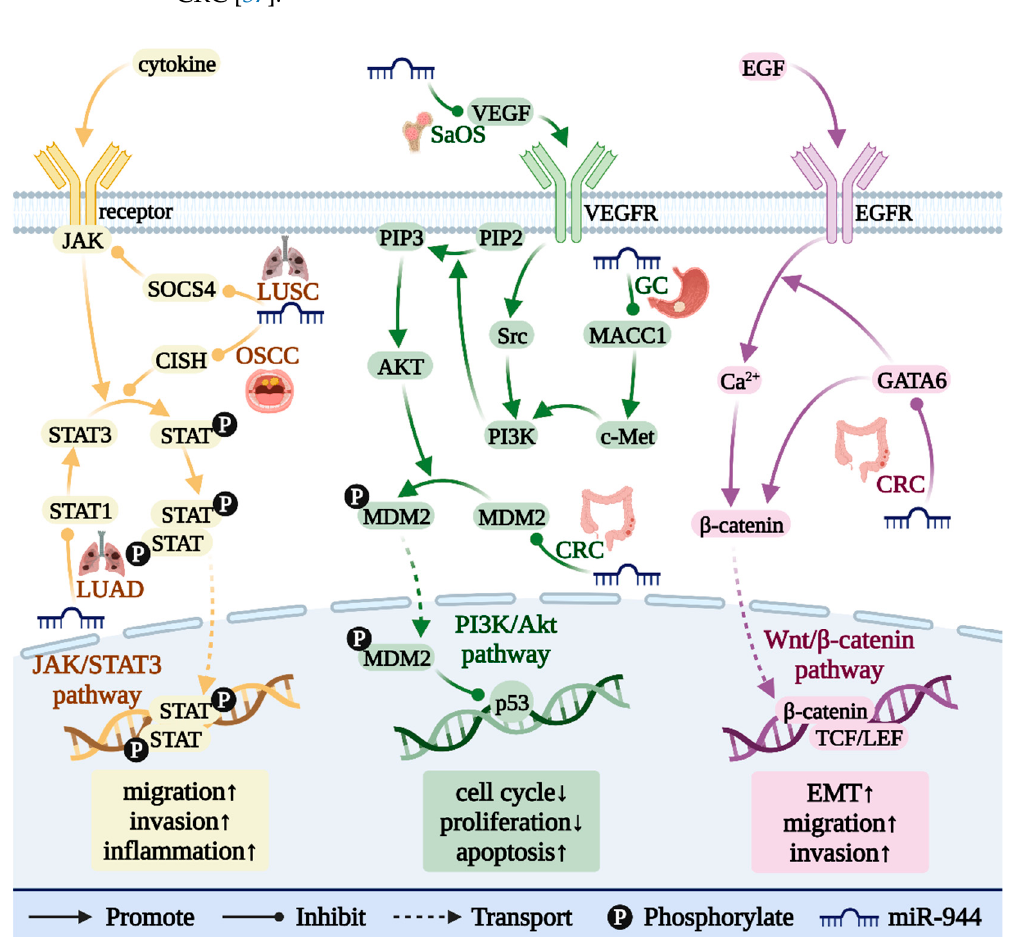
Figure 6. “ ↑ ”: activation of the signaling pathway will promote the cell behavior; “ ↓ ”: activation of the signaling pathway will inhibit the cell behavior. miR-944 is involved in the regulation of three signaling pathways. miR-944 plays a regulatory role in the occurrence and development of cancer by participating in the Wnt/ β -catenin, PI3K/AKT, and Jak/STAT signaling pathways.